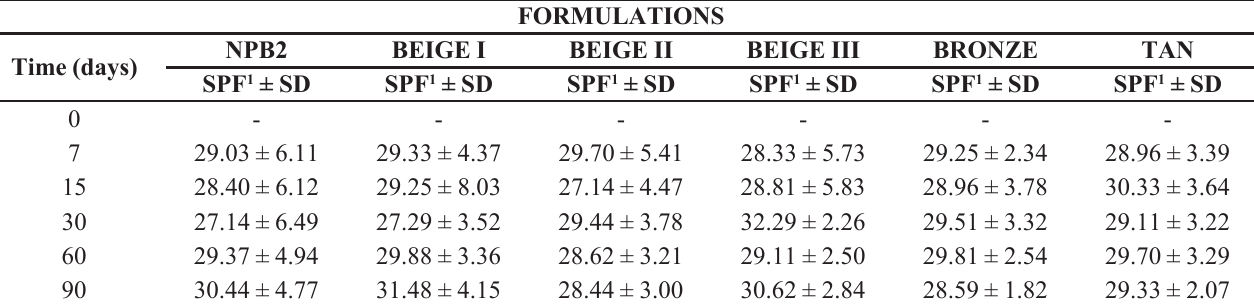
TABLE XIV - Results of SPF variation tests of the NPB2 base and corrective makeup stored at 37.0 ± 2.0 ºC for up to 90 days